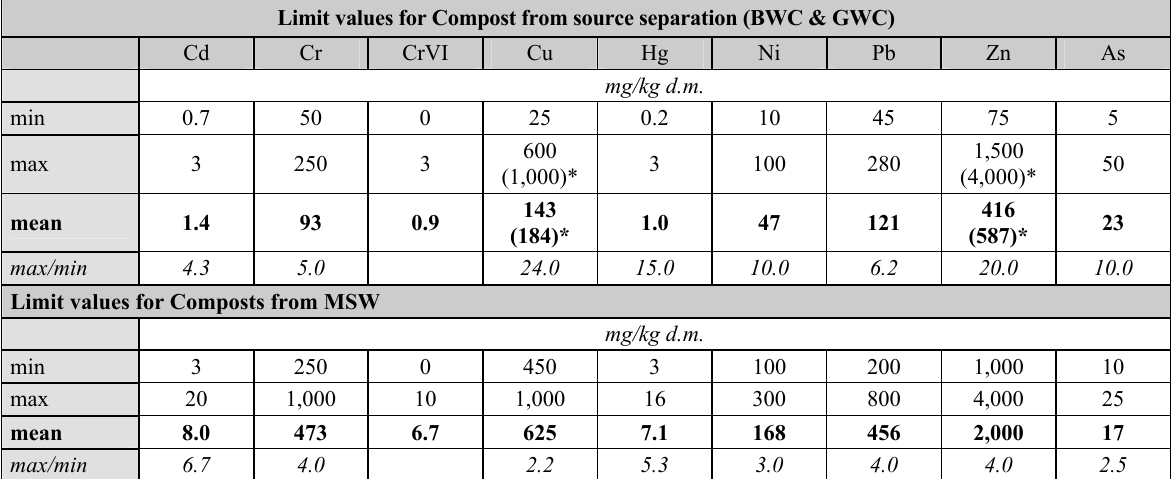
Maximum, minimum and mean limit values of PTEs for composts in Europe Limit values for Compost from source separation (BWC & GWC)